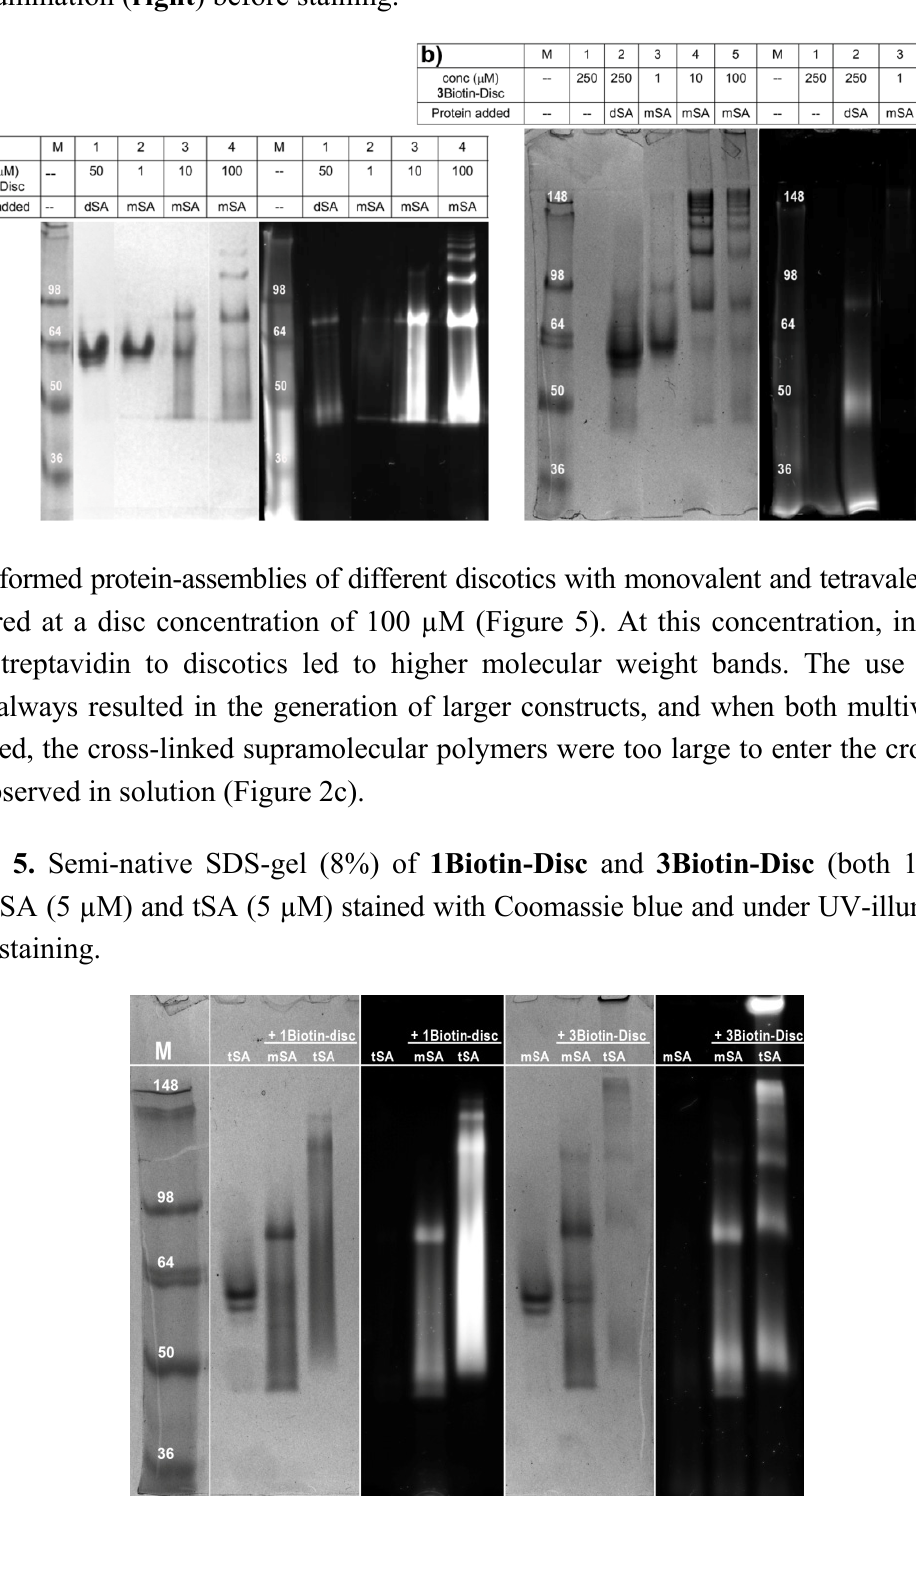
Figure 4. ( a ) Semi-native SDS-gel (8%) of different concentrations of 1Biotin-Disc and mSA (5 µM) or dSA (5 µM) stained with Coomassie blue ( left ) and under UV-illumination ( right ) before staining; ( b ) Semi-native SDS-gel (8%) of different concentrations of 3Biotin-Disc and mSA (5 µM) or dSA (5 µM) stained with Coomassie blue ( left ) and under UV-illumination ( right ) before staining.